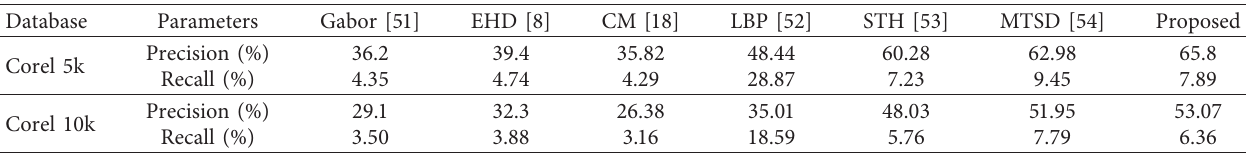
Table 12: Performance comparison of NRLGO with color, texture, and shape based state-of-the-art techniques on Corel 5k and Corel 10k.